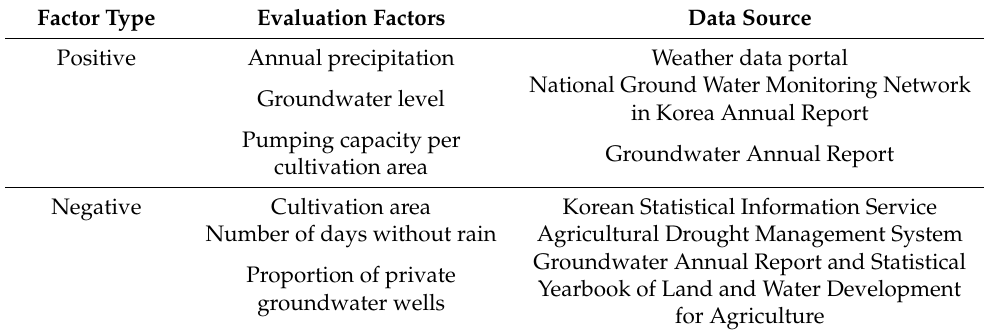
Table 1. The evaluation